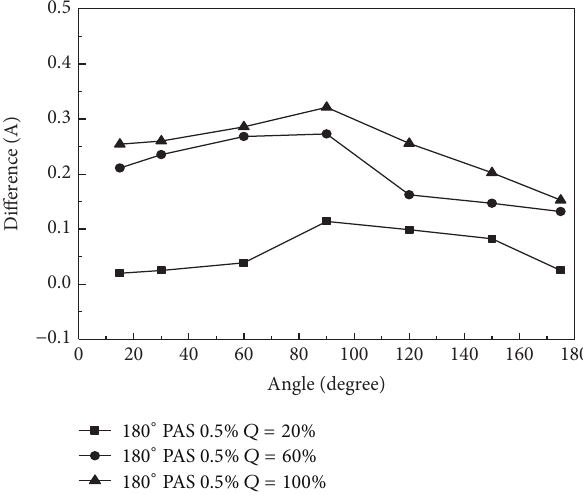
Figure 22: The PAS 0.5% angle of curved tube: difference diagram of various flows in 180 ∘ curved